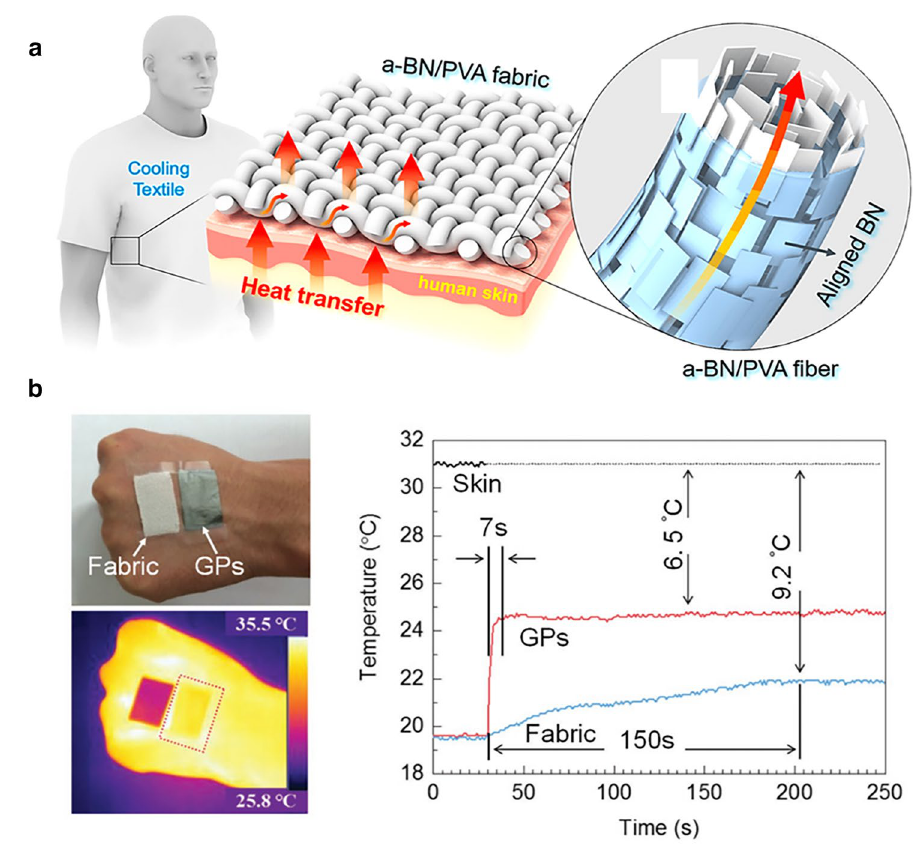
Fig. 12 a Schematic illustration of BNNS/PVA textile with high in‑plane k used in personal thermal management Reproduced with permission from Ref. [204]. Copyright 2017, American Chemical Society. b Photograph, infrared image, and the corresponding response time and heating transfer of normal cotton fabric and graphene film placed on skin. Reproduced with permission from Ref. [88]. Copyright 2017,